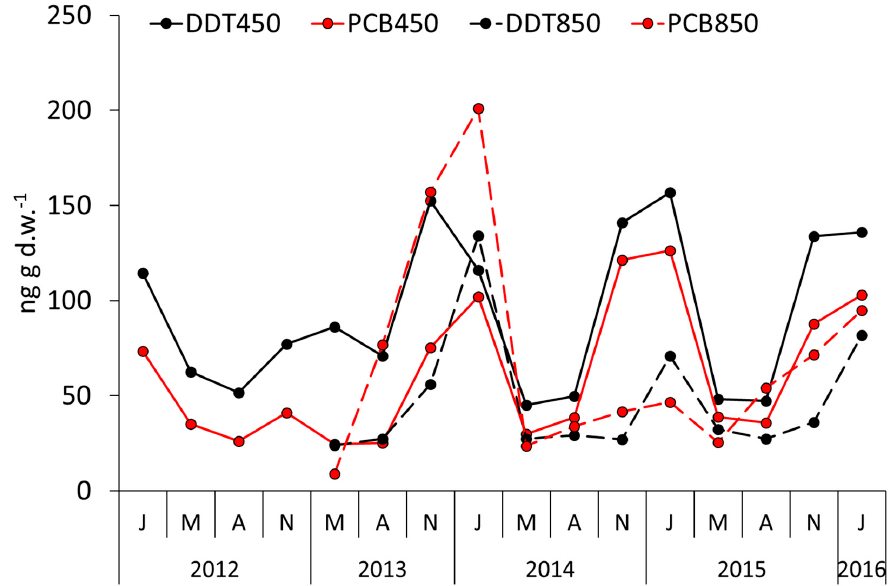
Figure A1. Concentration of POPs in two crustacean zooplankton size fractions ( ≥ 450 µm and ≥ 850 µm) of Lake Maggiore.